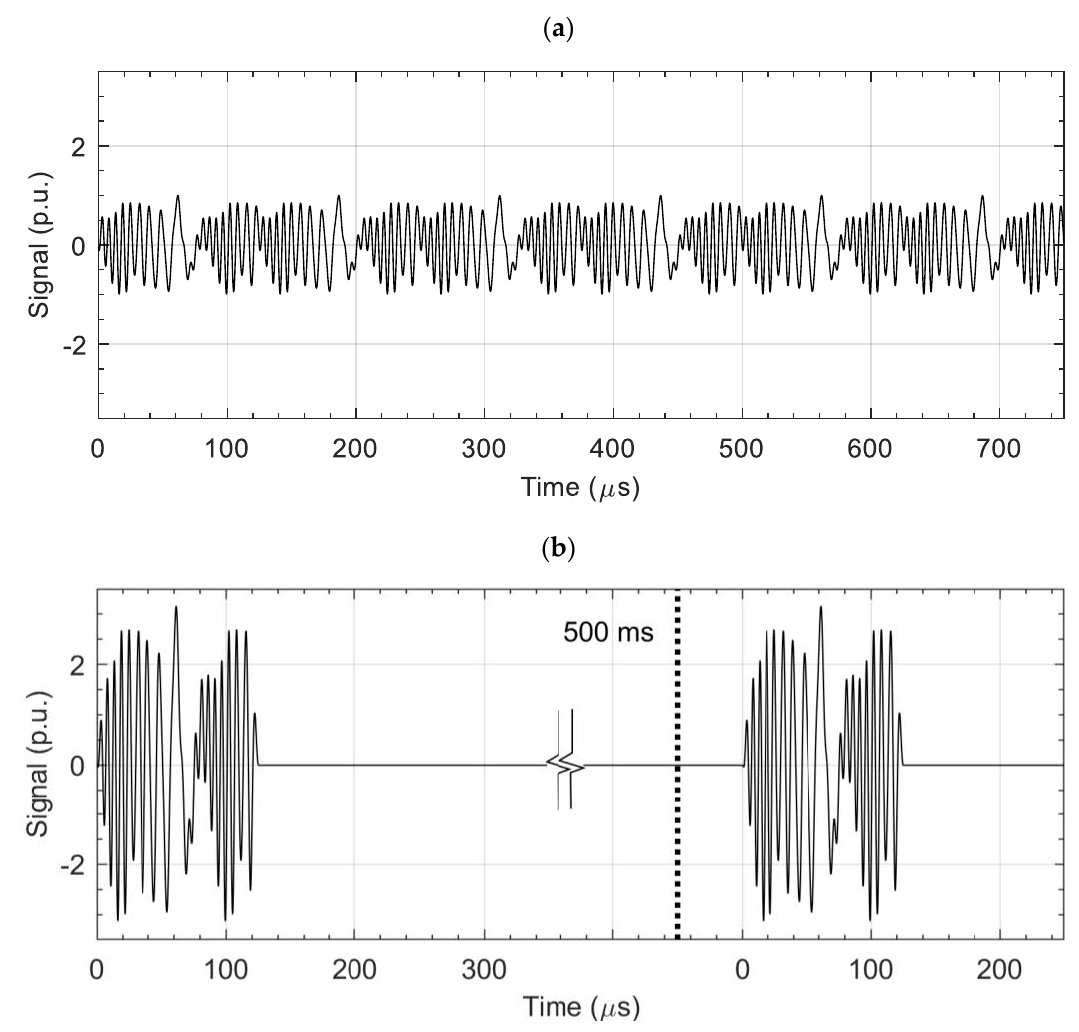
Figure 1. Comparison of excitation voltage for MFES-ECT ( a ) and PMFES-ECT ( b ). There is an interval of about 500 ms between successive pulses in the PMFES-ECT method. The pulse in PMFES-ECT has a power 10 dB more than in the MFES-ECT.